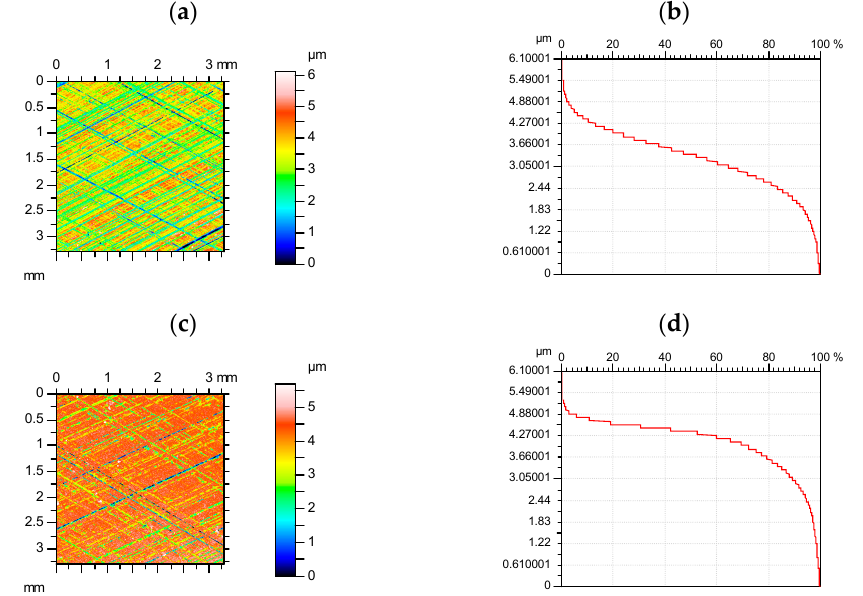
Figure 7. Color-code plots ( a , c ) and material ratio curves ( b , d ) of the random one-process ( a , b ) and two-process ( c , d ) surface of similar maximum height for vertical resolution of 100 nm. The peak density of 3D surface topography typically decreased, and the peak curvature increased due to quantization errors. The main directionality was constant. The